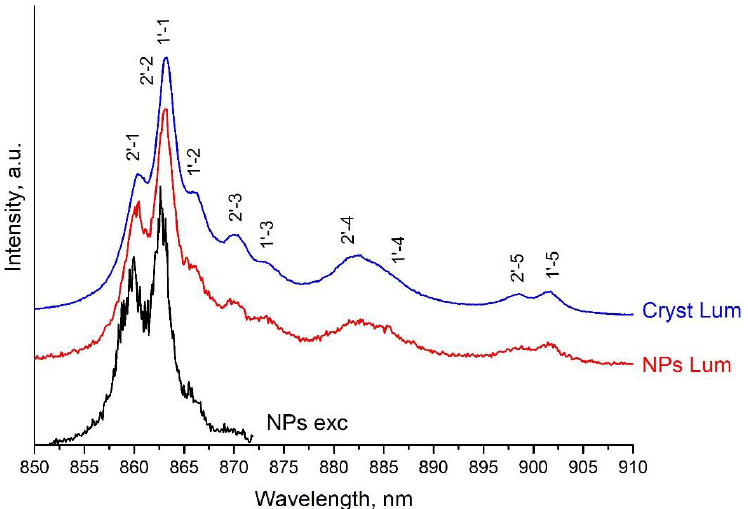
Figure 5. Energy level diagram of the Nd 3+ doped LaF 3 crystal (on the left) [35]: luminescence excitation transitions 4 I 9/2 → 4 G 5/2 + 2 G 7/2 (orange arrow) and 4 I 9/2 → 4 F 5/2 + 2 H 9/2 (red arrow) and fluorescence transition 4 F 3/2 → 4 I 9/2 (black arrows). Blue dashed arrows indicate multiphonon relaxation of electronic excitations. ( a ) Crystal field splitting levels (Stark levels) of the 4 I 9/2 and 4 F 3/2 manifolds of Nd 3+ ion in the Nd 3+ : LaF 3 crystal and ( b ) optical inter-manifold transitions between Stark levels 1’-1 and 2’-1 are shown.